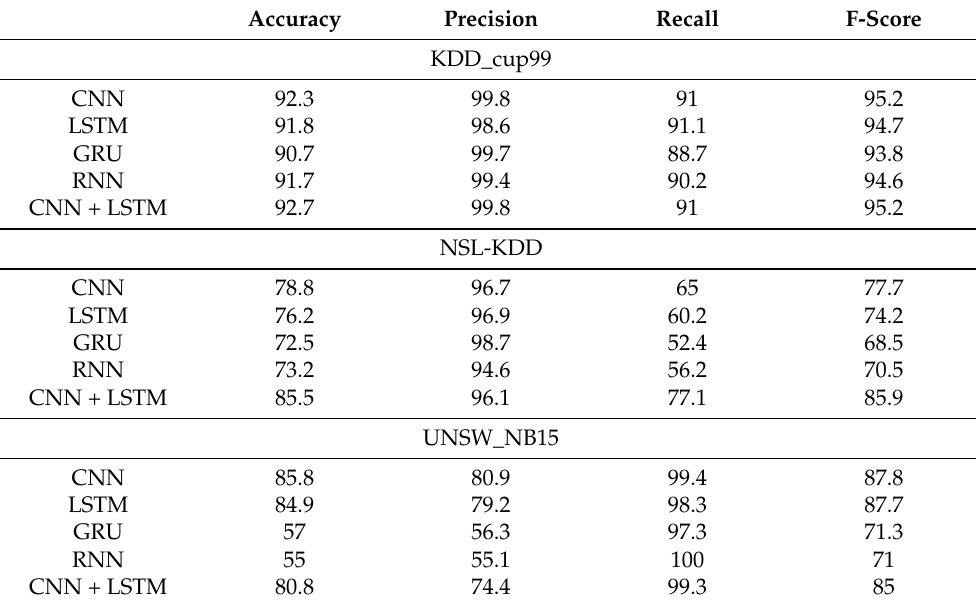
Table 2. First Experiment